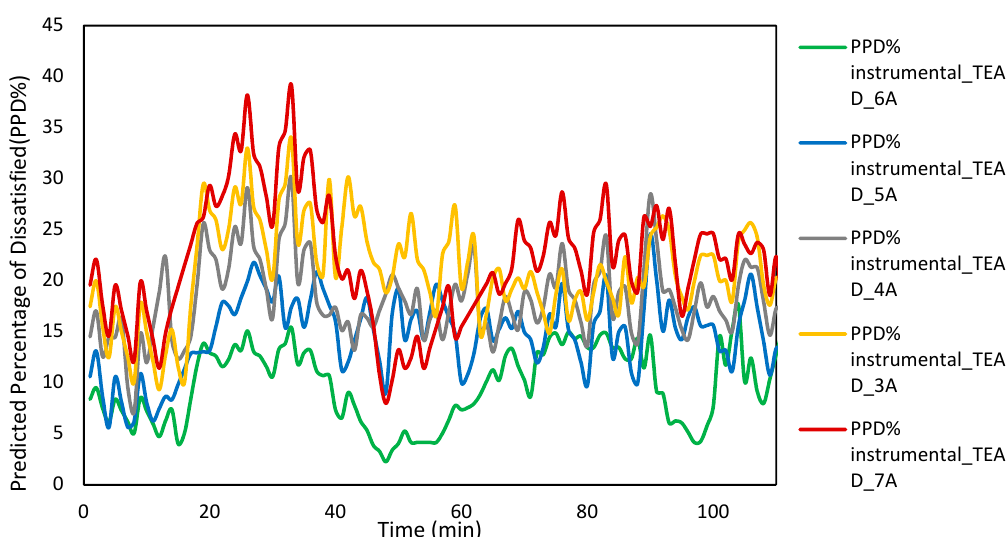
Figure 12. Variation of Predicted Percentage Dissatisfied (PPD %) at different operating powers.